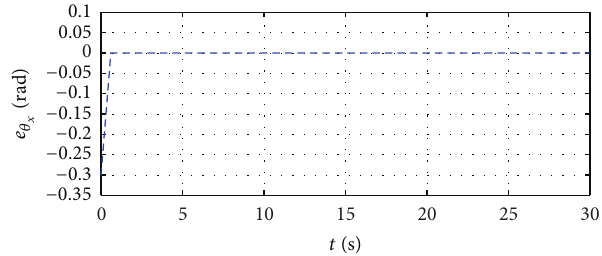
Figure 10: Theta error in 𝑥 direction. The error of angel theta in 𝑥 direction reaches its desired value which can be observed in the figure. The error tends to zero after 0.6 seconds.